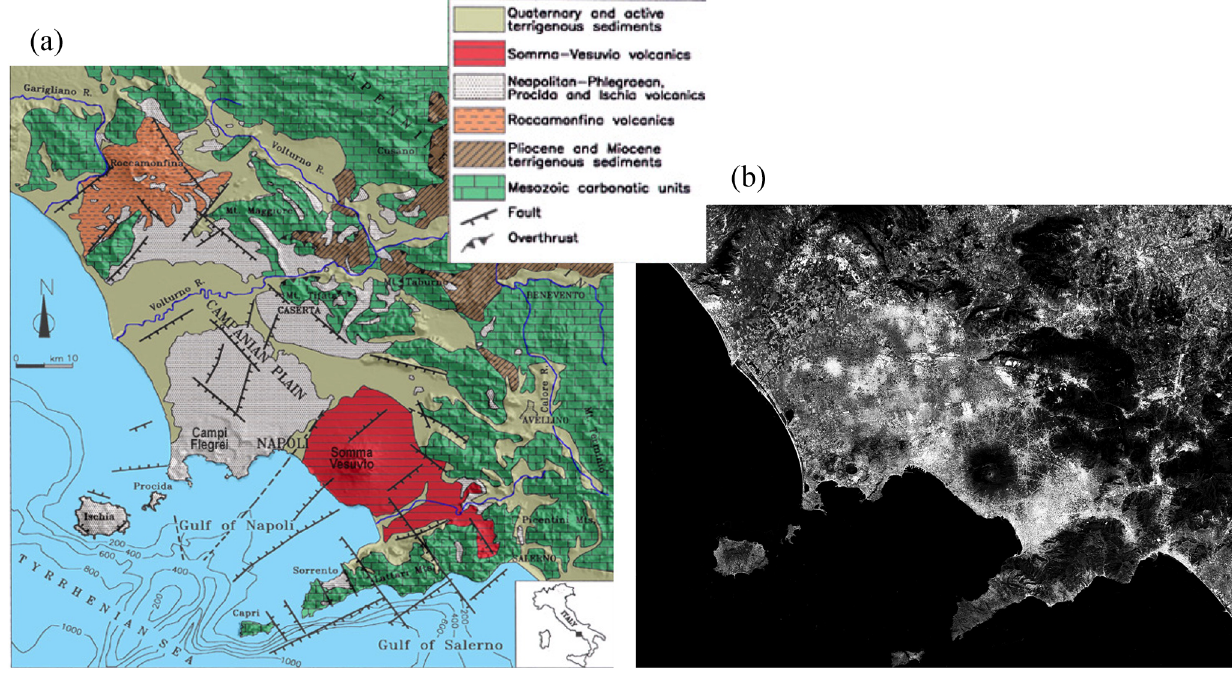
Figure 3. Geological sketch map of the Campanian Plain, with the Neapolitan volcanic area ( a ; modified from Orsi et al., 1996). Also shown ( b ; modified from © Google Earth) is a map with the most densely urbanised areas evidenced (more intense white means denser urbanisation). Note that more than 3 million people live in the volcanic area shown, thus making it the most risky in the world.